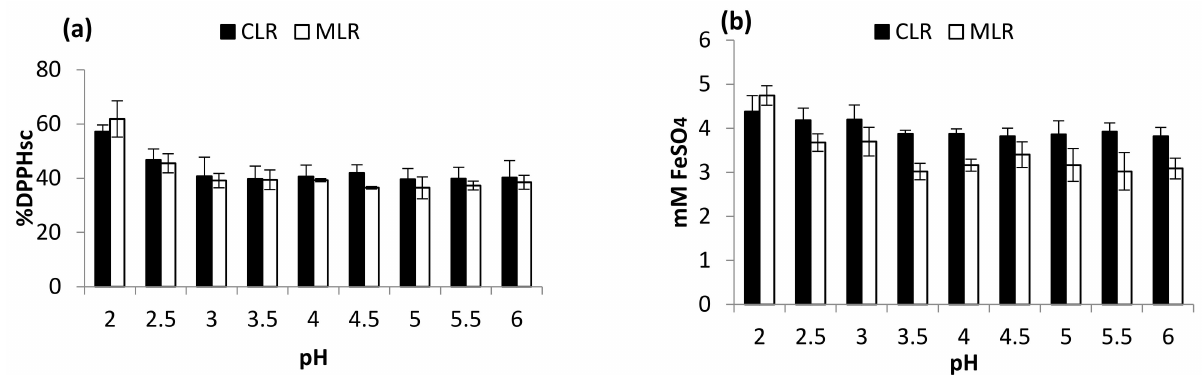
Figure 2. Effect of pH ( a ) DPPH scavenging activity and ( b ) ferric-reducing antioxidant power (FRAP).